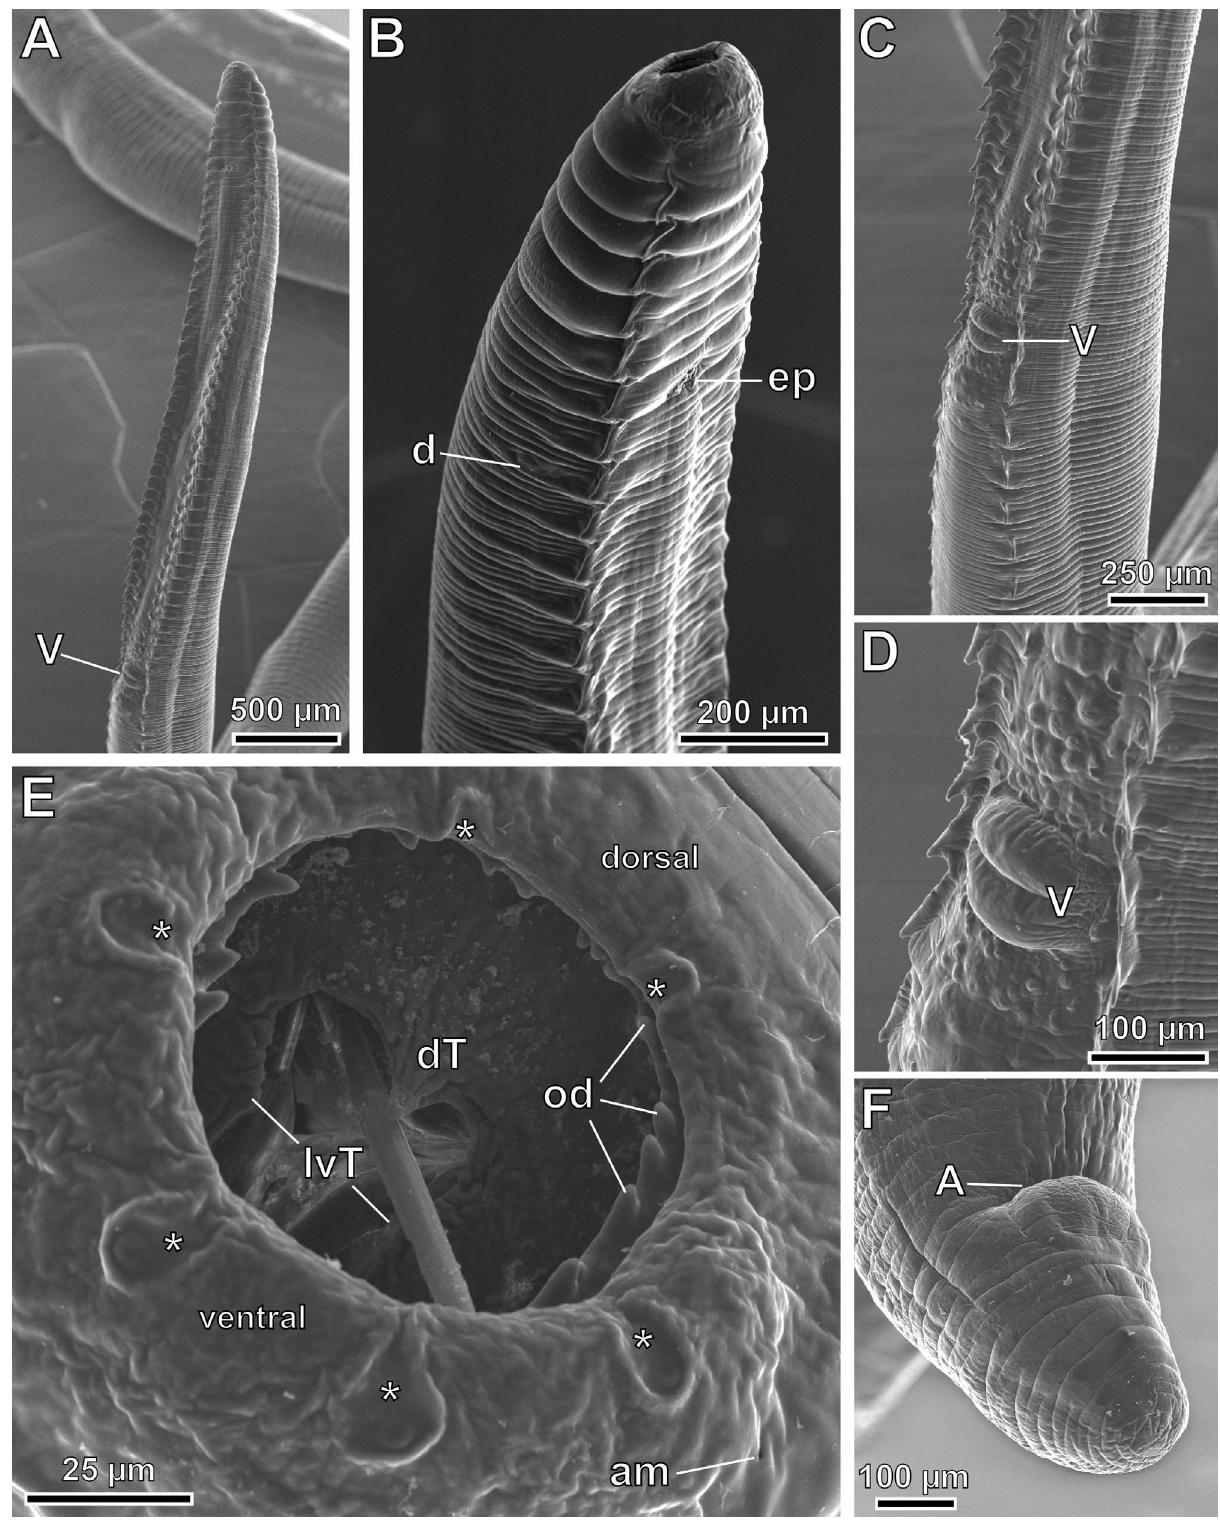
Figure 9. Pterygodermatites ( Mesopectines ) valladaresi n. sp., female, scanning electron microscopy. (A) General view of prevulvar region; (B) cephalic extremity, lateral view; (C) vulvar region; (D) detail of vulvar region showing the presence of numerous papillae; (E) detail of the oral opening; (F) posterior extremity. *, internal circle of 6 labial papillae; A, anus; am, amphid; d, deirid; dT, dorsal oesophageal tooth; ep, excretory pore; lvT, lateroventral oesophageal teeth; od, oral denticles; V,